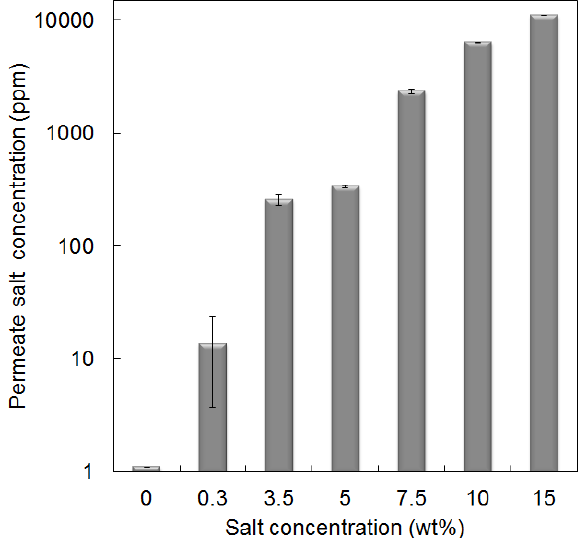
Figure 6. Permeate salt concentration as a function of the feed salt concentration at 22